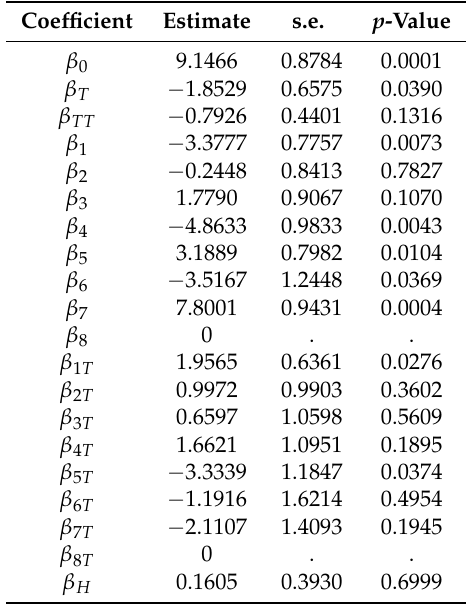
Table 6. GLS estimates for fixed effects of Model (6) related to